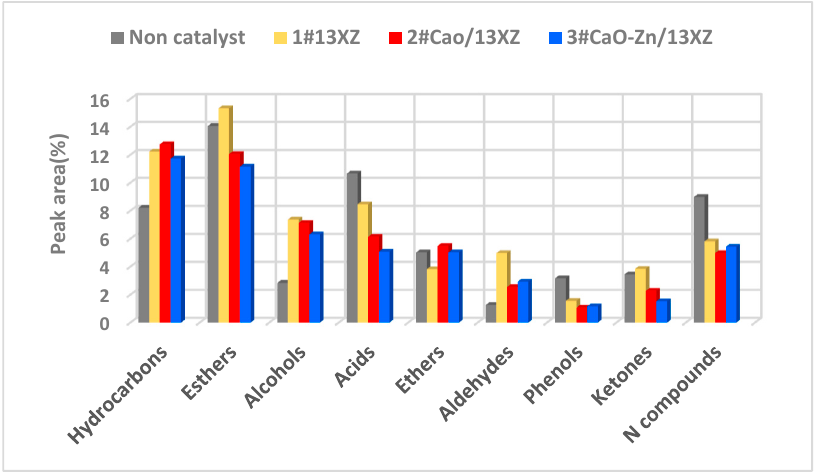
Figure 13. The components determined by GC-MS analysis in bio-oil at composition temperature of 550 °C, heating rate of 75 °C/min, 0.5 mm biomass particle size and a carrier gas flow rate of 80 mL/min.